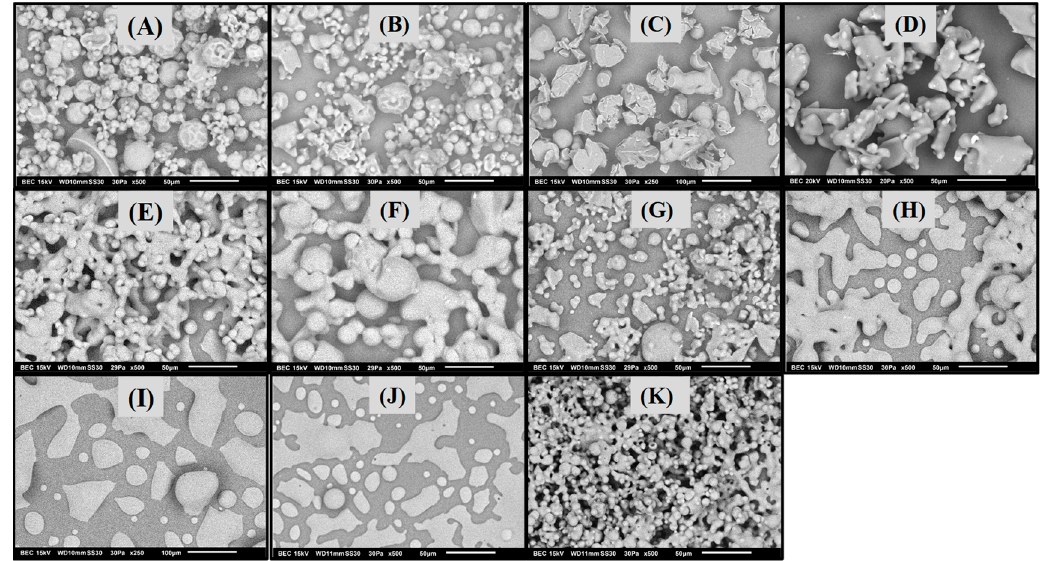
Figure 3. SEM micrographs of BJ-MX samples after the spray drying process. Run identification ( A ) 3, ( B ) 5, ( C ) 6, ( D ) 9, ( E ), 12, ( F ) 15, ( G ) 16, ( H ) 21, ( I ) 22, ( J ) 24, and ( K ) 25. Scale bar is equal to 50 μ m